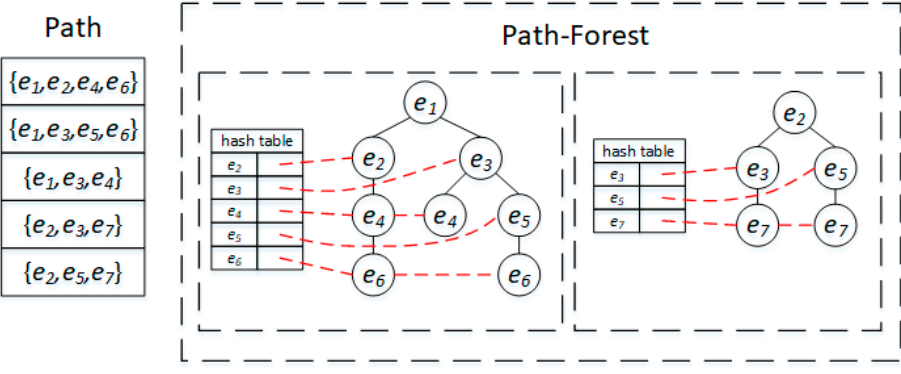
Figure 4. The Figure 4. The Path-Forest.